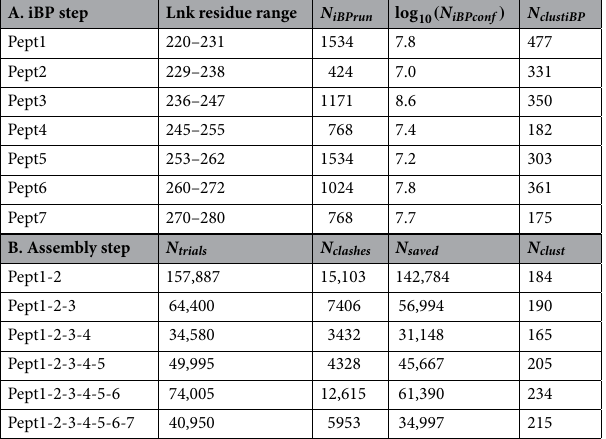
Table 1. TAiBP calculation. A. Peptide fragments sampling with iBP. Lnk was divided in 7 fragments spanning the residues 220–231 (Pept1), 229–238 (Pept2), 236–247 (Pept3), 245–255 (Pept4), 253–262 (Pept5), 260–272 (Pept6) and 270-2-80 (Pept7). N iBPrun : cumulative numbers of iBP runs for all sampled φ , ψ boxes on a given fragment. N iBPconf : cumulative numbers of generated conformations in the iBP runs for all parsed restraints on a given fragment. N clust : number of conformations after the clustering using self-organizing maps 32 . B. Assembling the 7 fragments Pept1 to Pept7 spanning Lnk. Each assembly step is labeled “Pept” followed by the index of assembled fragments and describes the addition of the last index fragment to the protein obtained at the previous assembly step. N trials : number of trials during the assembly run. N clashes : number of solutions removed because of C α atoms closer than 1 Å. N saved : number of solutions before clustering. N clust : number of solutions after clustering using self-organizing maps 32